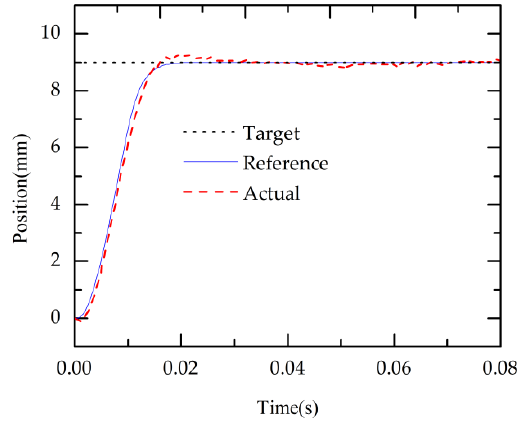
Figure 14. Experimental results for the control system using a position sensor: ( a ) Position; and ( b ) Velocity.